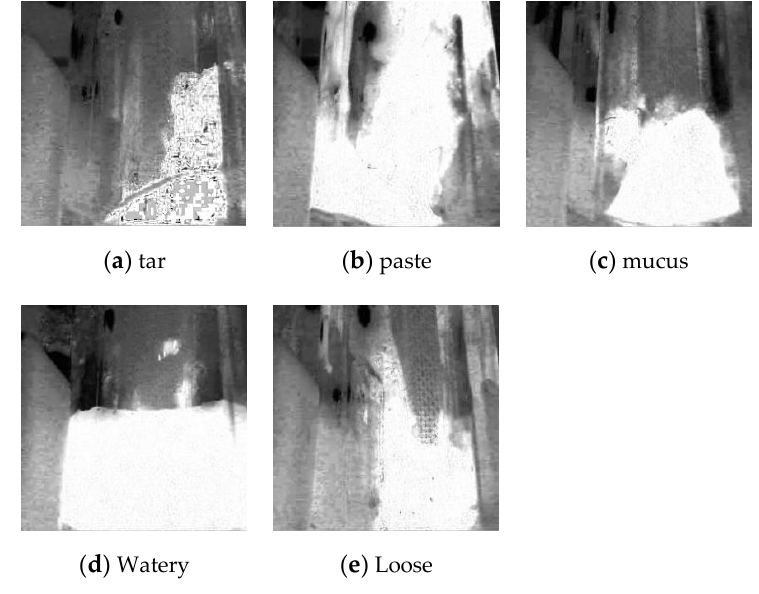
Figure 4. Saturation maps of different classes.